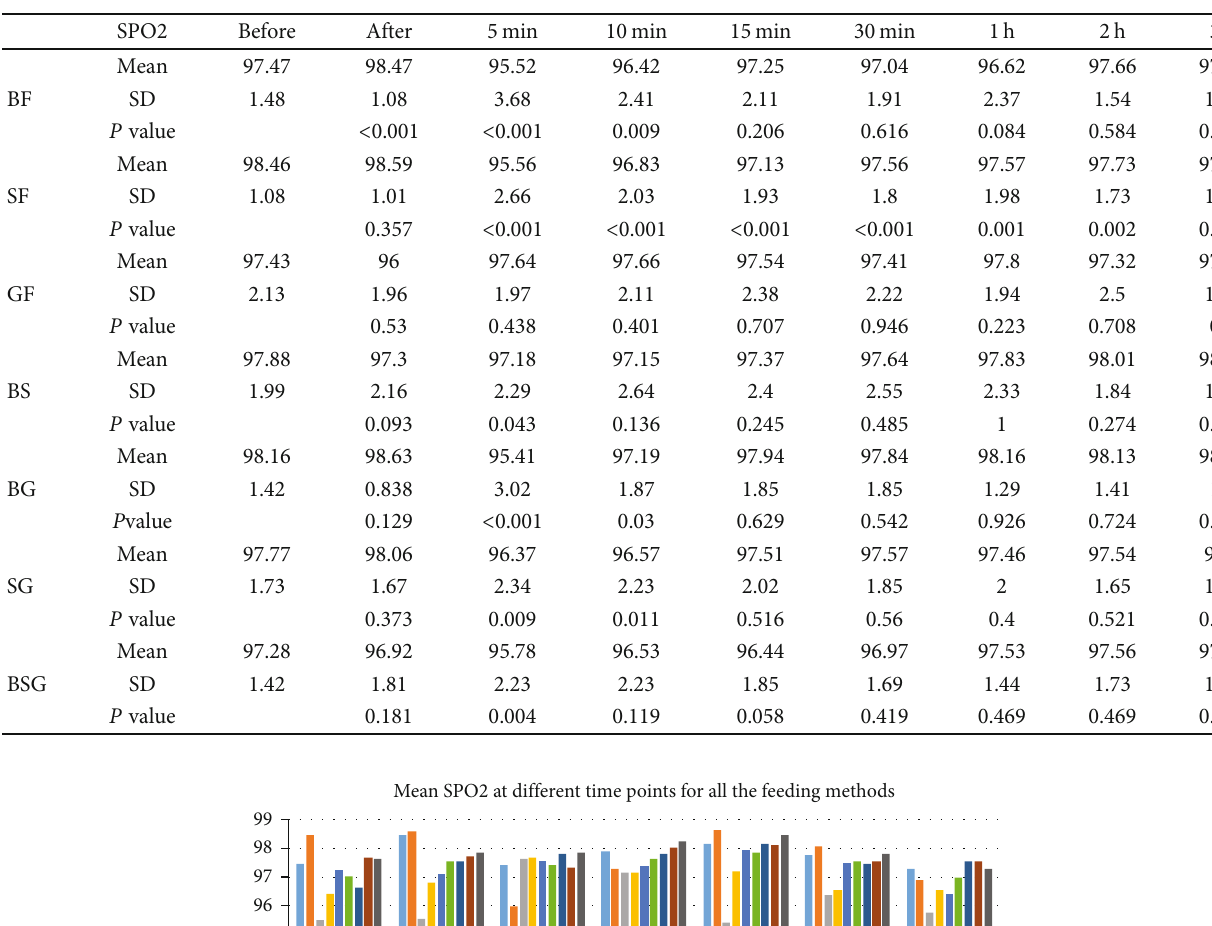
Table 4: SPO2 at di ff erent time points for all the feeding methods.